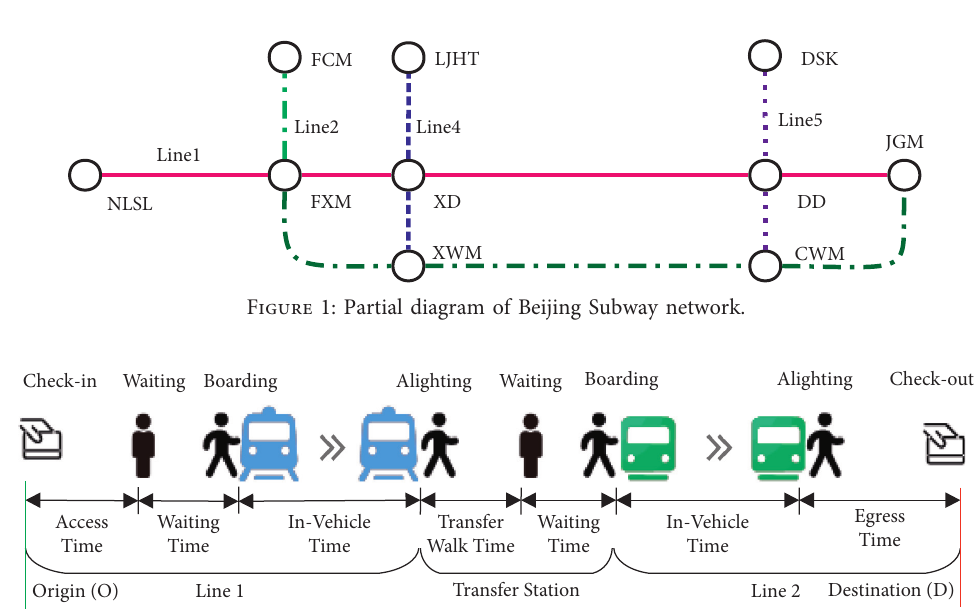
Figure 2: Passenger travel diagram by